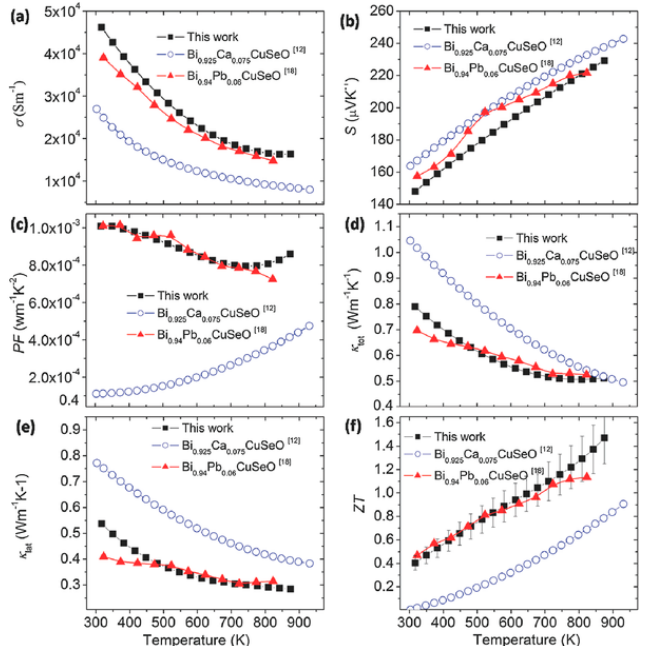
Figure 12. Thermoelectric properties of Pb and Ca dual-doping, Ca single doped (Bi 0.925 Ca 0.075 CuSeO) and Pb (Bi 0.94 Pb 0.06 CuSeO) single doped samples ( a ) the electrical conductivity; ( b ) the Seebeck coefficient; ( c ) the power factor; ( d ) total thermal conductivity; ( e ) lattice thermal conductivity; and ( f ) the figure of merit ZT . Reproduced with permission from Reference [10]. Copyright 2016,